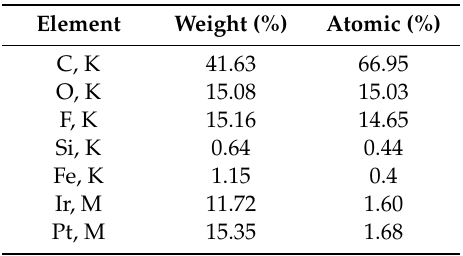
Figure 6. Scanning Electron Microscopy (SEM) image of membrane electrode assembly (MEA) depicting even catalyst loading. Table 5. Energy Dispersive Spectroscopy (EDS) result of Membrane Electrode Assembly (MEA) for anode (oxygen) side.